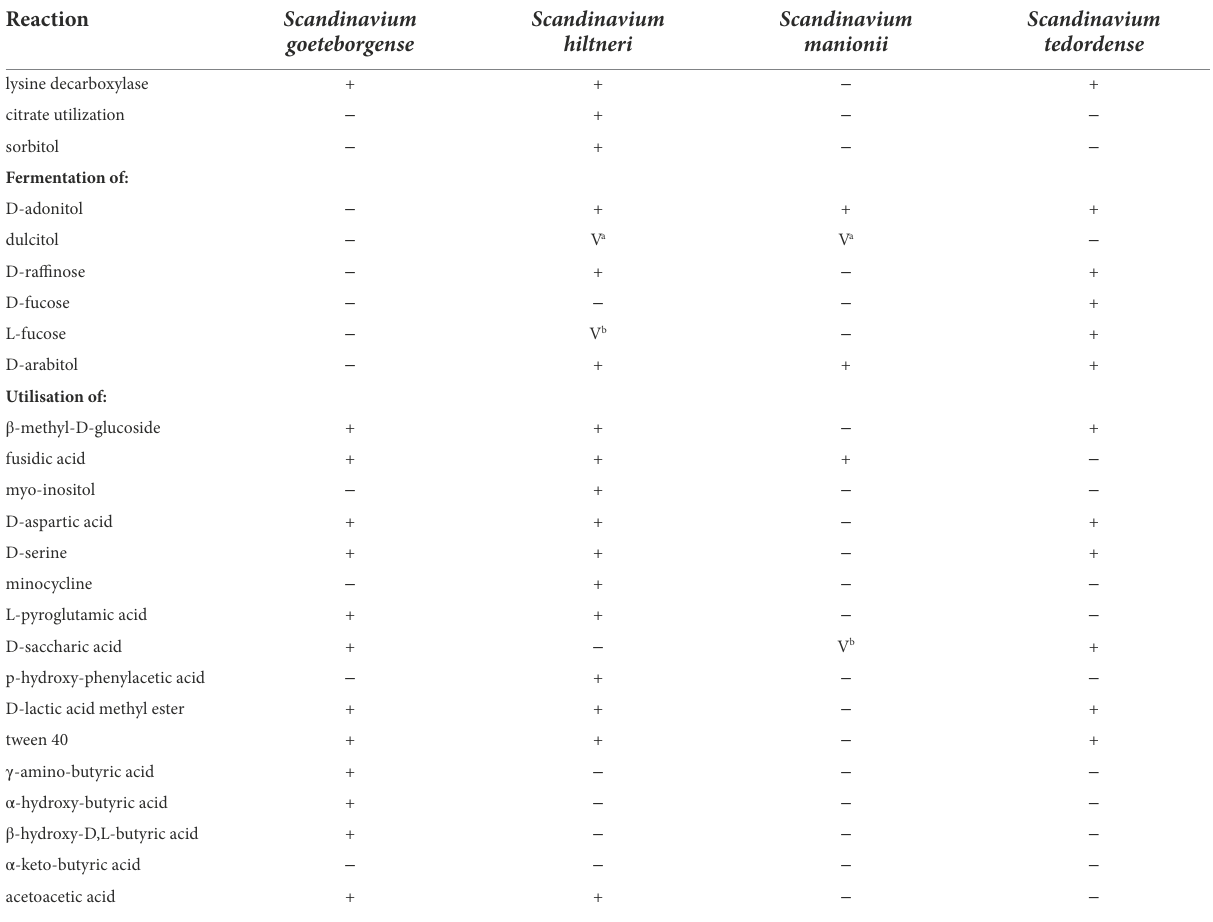
TABLE 2 Key phenotypic characteristics that allow for the differentiation of all known members of the genus Scandinavium .